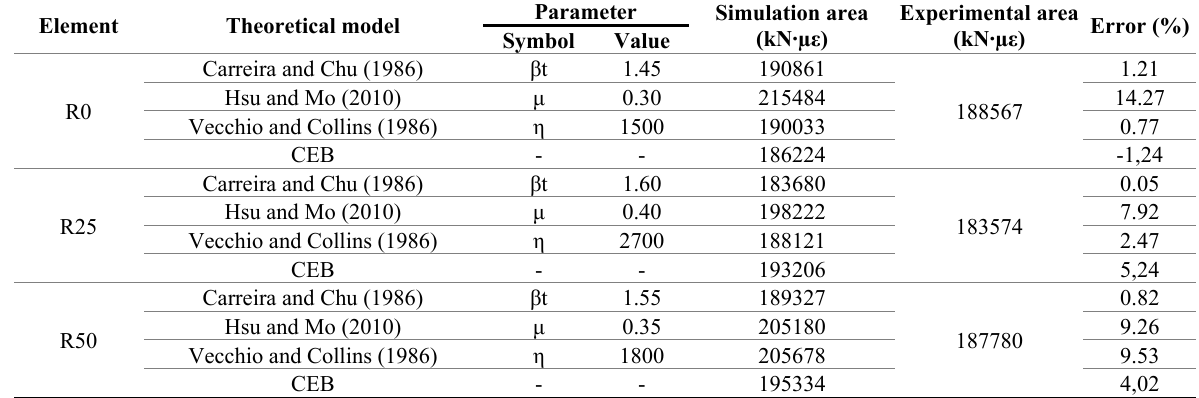
Table 7. Comparison between numerical, analytical and experimental results of reinforced concrete tension stiffening elements.